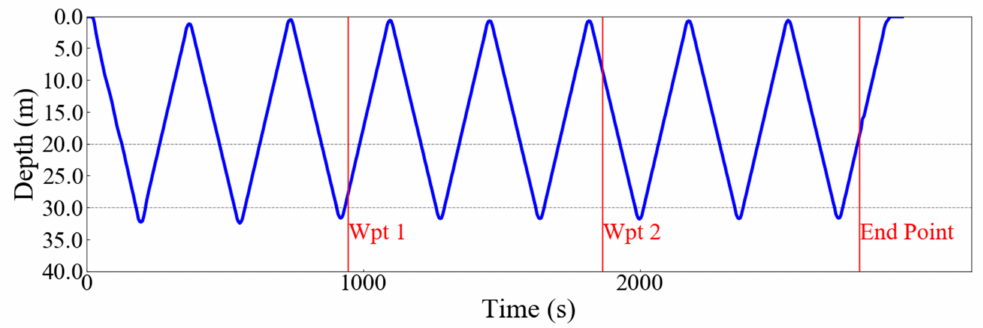
Figure 23. The depth of the glider under the control of the waypoint controller, which changed the target point adaptively and activated the surface behavior when the end point was